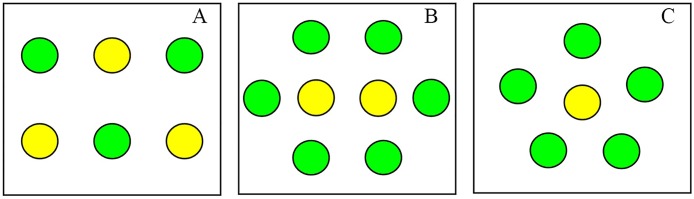
Arrangement of tomato plants in cages in the fungal experiment 1.A: 3 TY-plants (yellow) and 3 normal plants (green) (3/3 cage), B: 2 TY-plants and 6 normal plants (2/6 cage), C: 1 TY-plant and 5 normal plants (1/5 cage).